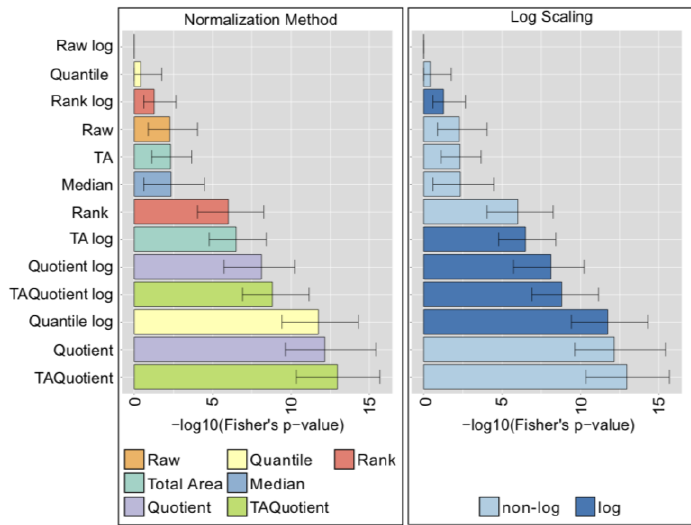
Figure 4. Ultra High Performance Liquid Chromatography with Fluorescence Detection (UHPLC-FLD) normalization analysis results (Colorectal cancer controls cohort). Results in the panels are colored according to type of normalization (left), or log-transformation (right). Bars represent the median of the Fisher’s exact test p -values over 1000 bootstrapping, and error bars indicate the corresponding 95% confidence intervals.